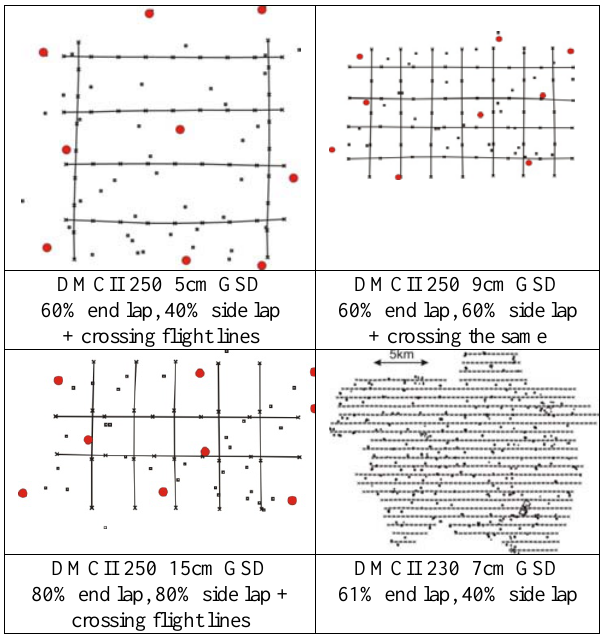
Fig. 1 : flight and control/check point configuration of the DMCII 250 test flights and the DMCII 230 operational flight